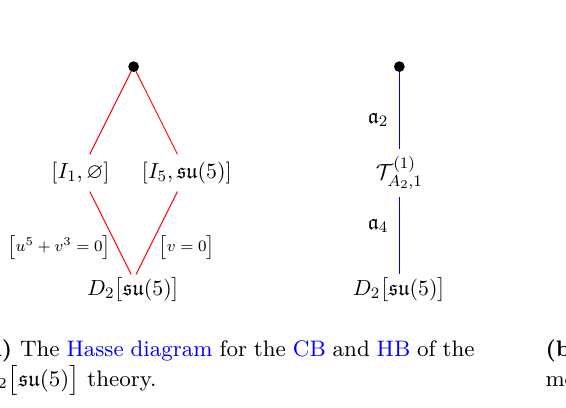
(cid:2) su (5) (cid:3) AD